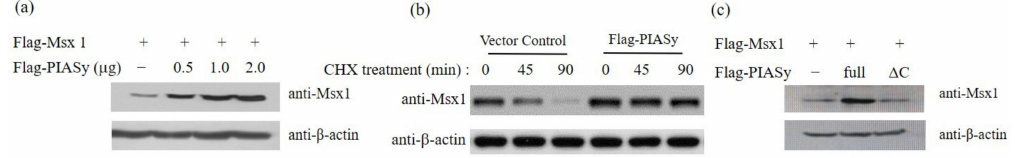
Figure 5. Msx1 protein stabilization by PIASy. ( a ) PIASy stabilizes Msx1 protein. Human ovarian cancer 2774 cells were co-transiently transfected with plasmid as indicated, and whole cell lysates were prepared and processed for immunoblot analysis with the indicated antibody. β -actin was used as a control. ( b ) PIASy increases the half-life of Msx1 protein. Human ovarian cancer 2774 cells were transiently transfected with the vector control or Flag-PIASy plasmid as indicated, and cycloheximide was added at the indicated time point. Whole cell lysates were prepared for immunoblot analysis with anti-Msx1 antibody. β -actin was used as a control. ( c ) C-terminal PIASy domain is critical for PIASy-mediated Msx1 protein stabilization. Human ovarian cancer 2774 cells were transfected with wild-type PIASy (full) or mutant PIASy construct lacking Msx1-interacting C-terminal domain ( ∆ C) and then processed for immunoblot analysis with the indicated antibody to assess the stabilization of Msx1 protein. β -actin was used as a